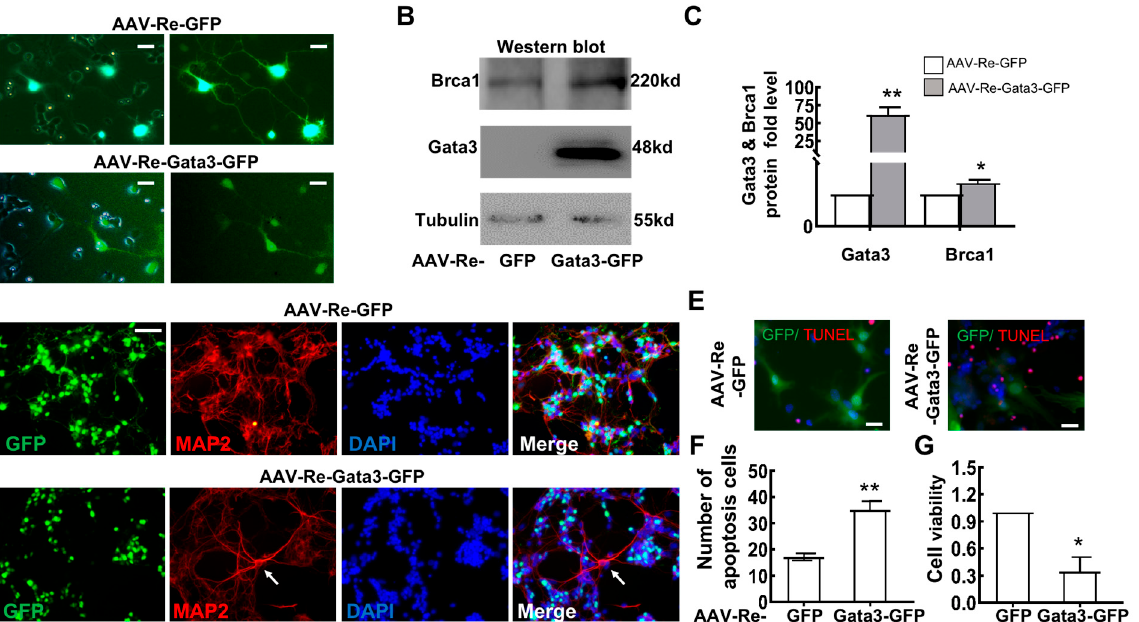
Figure 7. Brca1 might be transcriptionally regulated by Gata3 in vitro. ( A ) Primary retinal neurocytes (P1) were infected with AAV-Re- Gata3 -GFP (green) or AAV-Re-GFP (green) adenoviruses. ( B ) AAV-Re- Gata3 -GFP transfection upregulated the expression of not only Gata3 but also Brca1 in primary retinal neurocytes. ( C ) The relative protein expression levels of Gata3 and Brca1 are presented as histograms. ( D ) Gata3 overexpression impeded differentiation in primary retinal neurocytes, as evidenced by staining with anti- Map2 (red) in primary retinal neurocytes treated as above (green). ( E ) The number of apoptotic cells is presented as a histogram. ( F ) Exogenous Gata3 significantly reduced the viability of primary retinal neurocytes. The asterisks indicate statistically significant differences (* p < 0.05, ** p < 0.01). Scale bars represent 20 μ m.